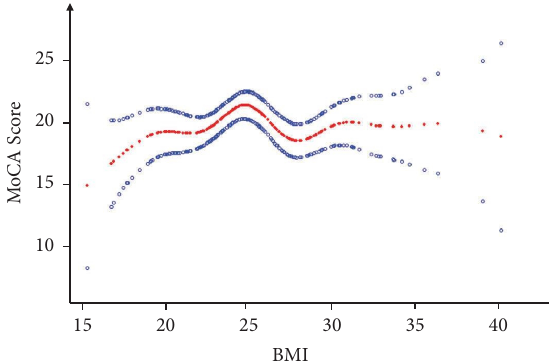
Figure 2: Association between BMI and cognitive function of atrial fbrillation. A threshold and a non-linear relationship between BMI and MoCA score were found in a generalized additive model. Te solid red line represents the smooth curve ft between variables. Blue bands represent the 95% confdence interval from the ft. Models were adjusted for age, sex, smoking or not, alcohol consumption, marital status, degree of education, living condition, aspirin, warfarin, history of myocardial infarction, cerebral infarction history, diabetes mellitus, hypertension, valvular disease, hyperlipidemia, coronary artery disease, heart failure, SBP, DBP, D -dimer, creatinine, FT4, FT3, left atrial